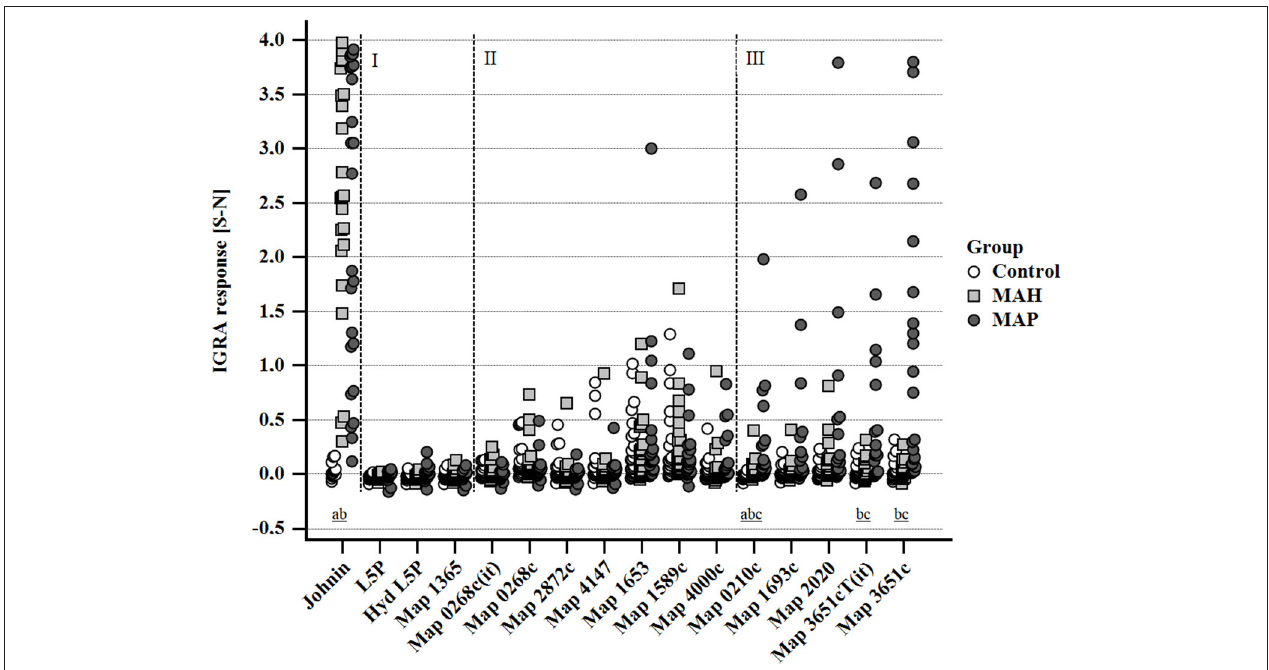
FIGURE 5 | Whole blood IFN- γ response of MAH or MAP inoculated goats vs. control animals induced by PPDj (5 µ g/mL) and different MAP antigens (10 µ g/mL each). Cluster I: very weak IFN- γ responses in all three groups of animals; cluster II: IFN- γ responses with similar magnitude and no group differences; cluster III: increased IFN- γ responses in MAP-inoculated goats. Data of three time points (19–22, 27–30, and 45–48 wpi) are summarized. Each dot represents one animal. Different letters indicate significant differences between the groups: a—control vs. MAH, b—control vs. MAP, c—MAH vs. MAP (Tukey-Kramer post-hoc test, P <